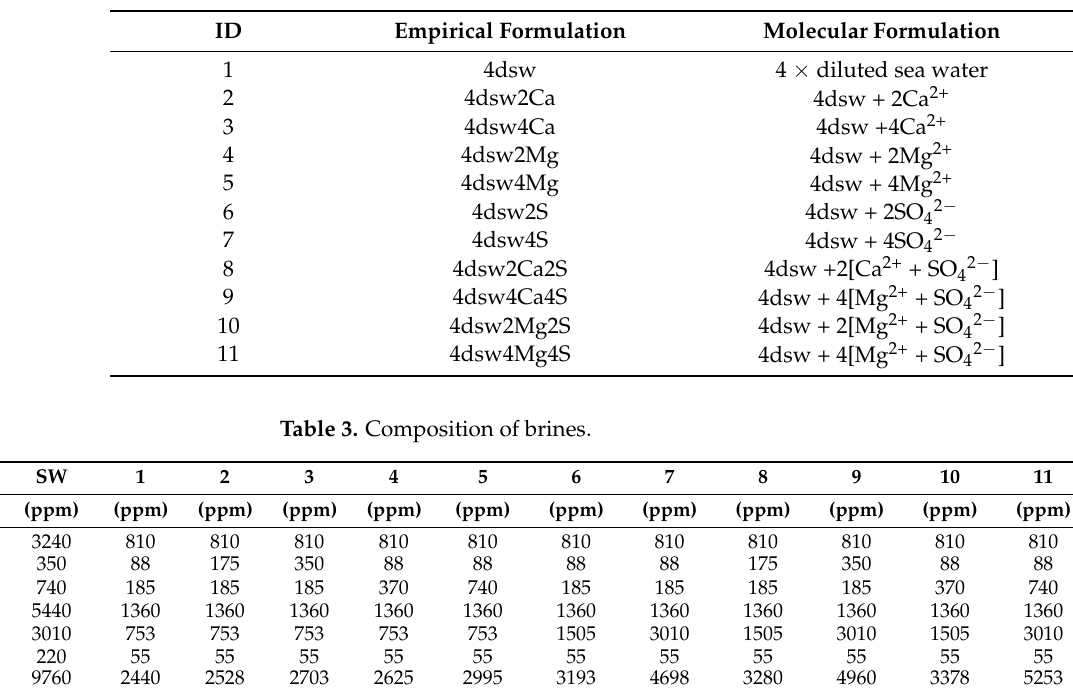
Table 2. Notation used for EW samples.